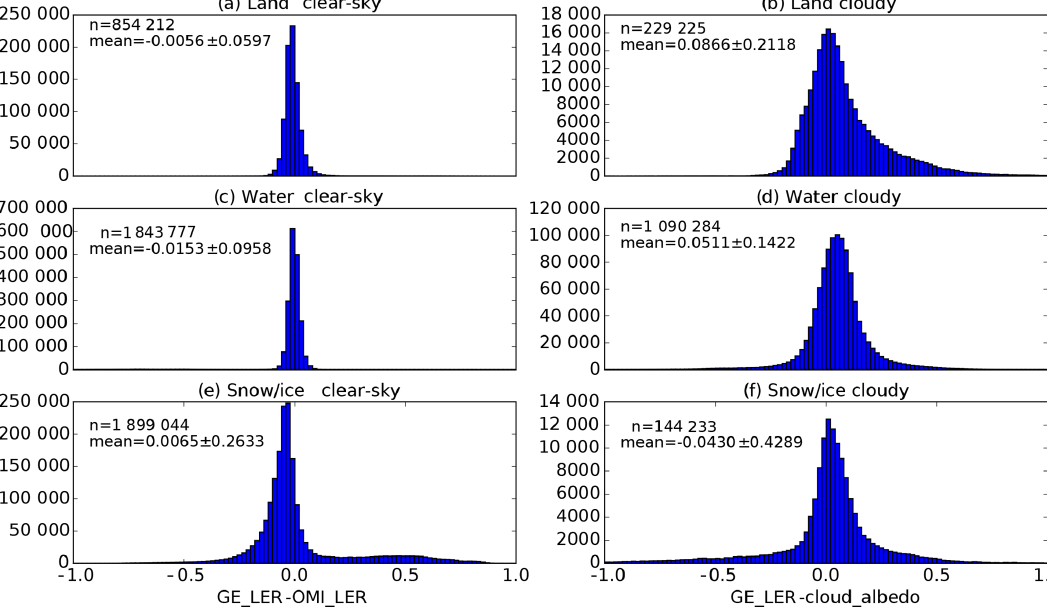
Figure 7. Histograms of the differences (a, c, e) between clear-sky TROPOMI GE_LER and OMI LER climatology and (b, d, f) between the cloudy TROPOMI GE_LER and the ROCINN_CRB cloud albedo from the operational S5P cloud product. The comparisons are performed separately according to surface types (land, water, and snow/ice), with S5P data from 10 April